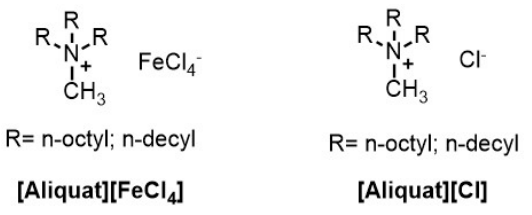
Figure 1. Molecular structures of the ionic liquids used in this